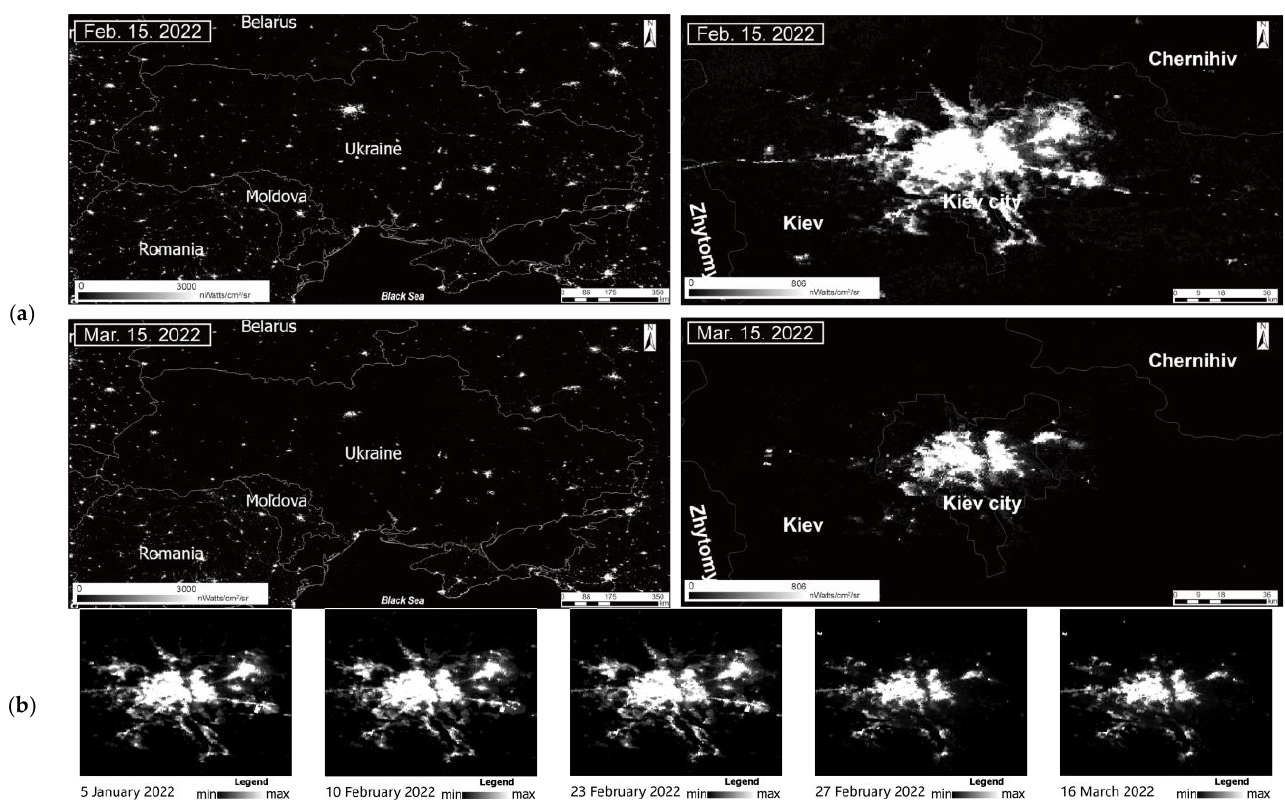
Figure 1. ( a ) A snapshot comparison of regional night lights before and after the Ukrainian-Russian conflict; ( b ) Time-series of light images in Kiev